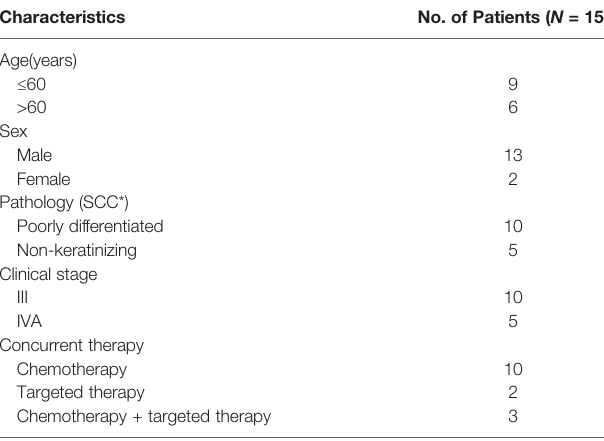
TABLE 2 | The dose – volume constraints of normal tissues in NPC. Structures